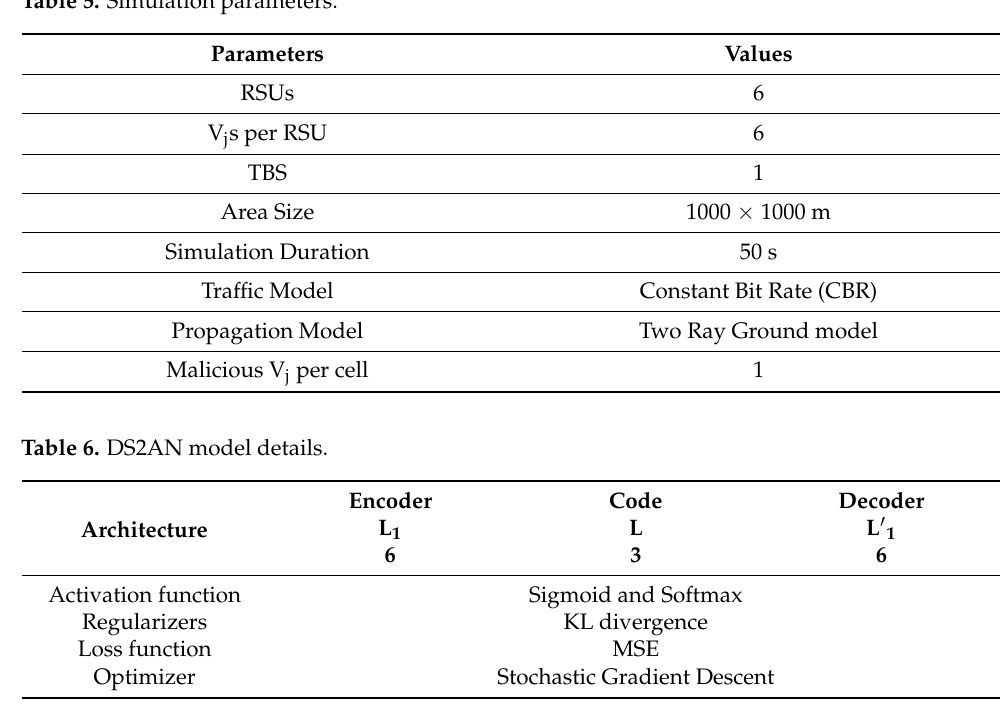
Table 5. Simulation parameters.